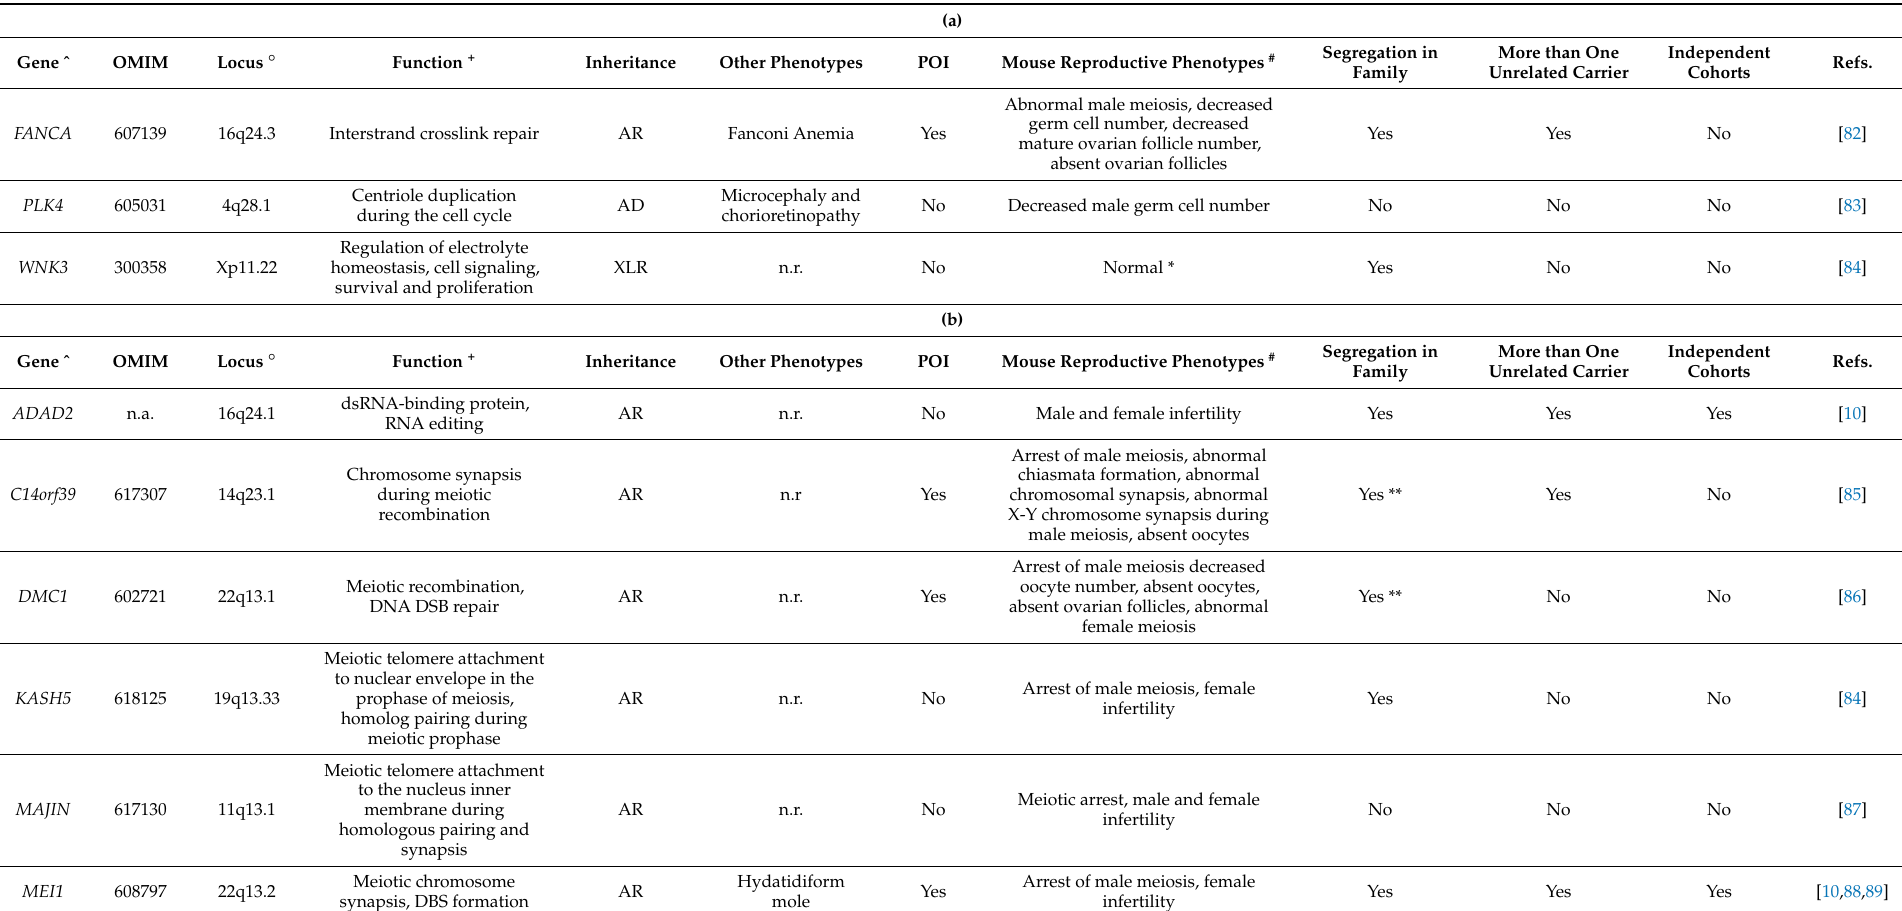
Table 1. List of candidate genes involved in monogenic causes of Human NOA, divided according to the associated-testis histology: ( a ) SCOS phenotype, ( b ) maturation arrest phenotype, ( c ) different types of testicular phenotype (SCOS/MA/hypospermatogenesis) and ( d ) undefined testicular phenotype. Detailed genomic and clinical information, the female and male mouse reproductive phenotypes and references are